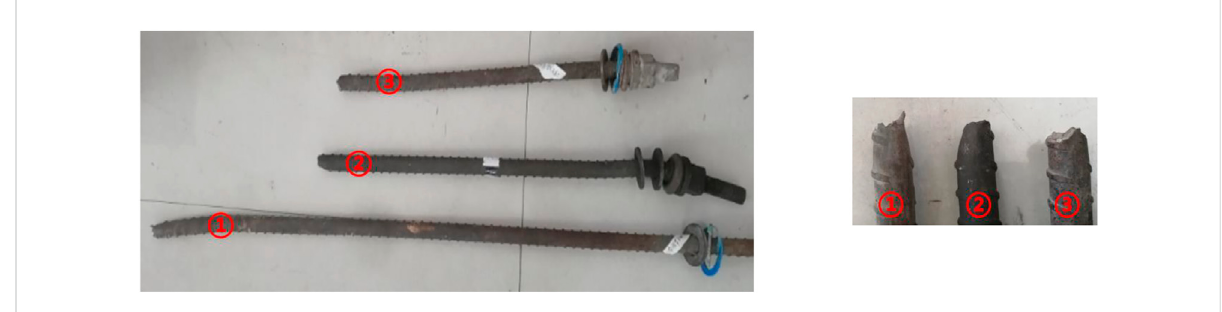
FIGURE 2 Breaking form of bolts.